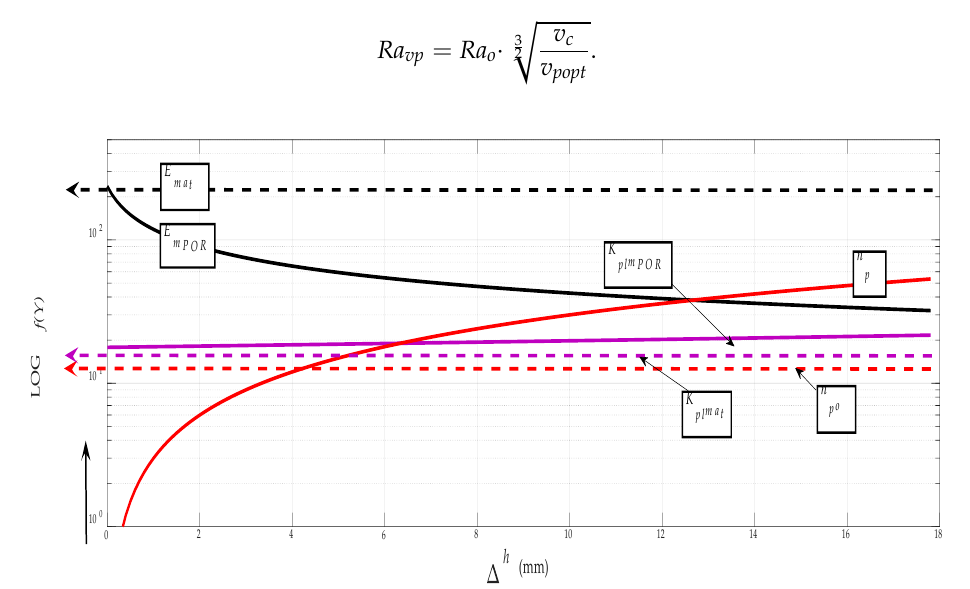
Figure 12. Porosity ( n pX ) = f ( ∆ h ) for Stellite.